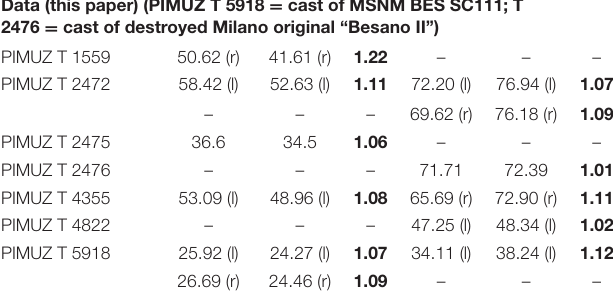
Data taken from Fraser and Furrer (2013, p. 203, table